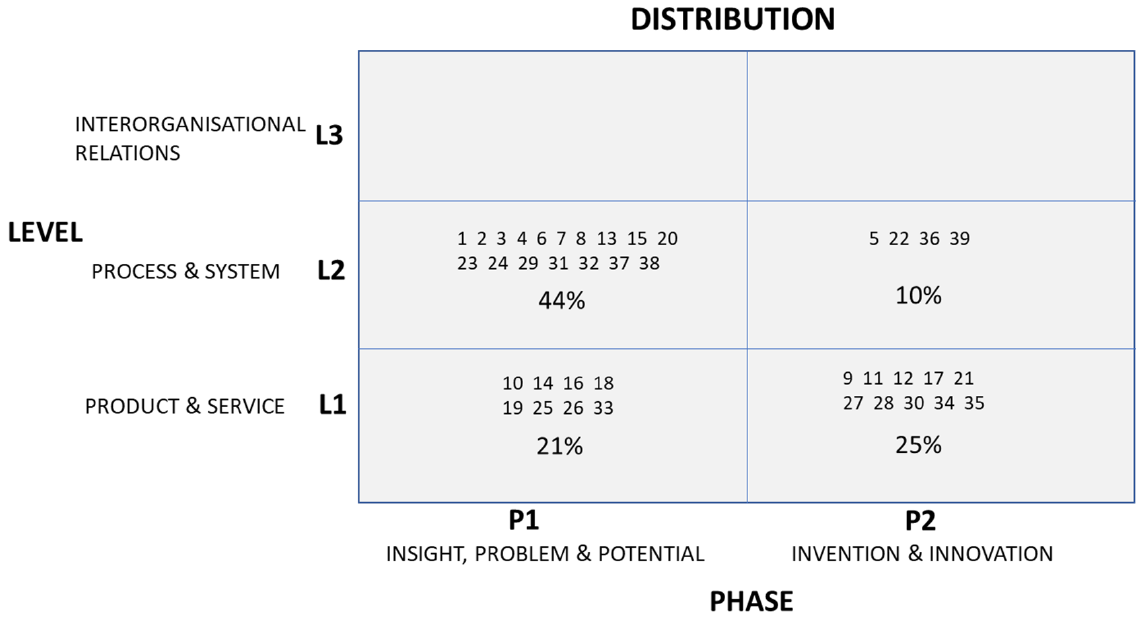
Figure 8. Articles plotted in two-dimensional of coding by phase and level. Each article is numbered, where the lowest number corresponds to the highest citation rate.